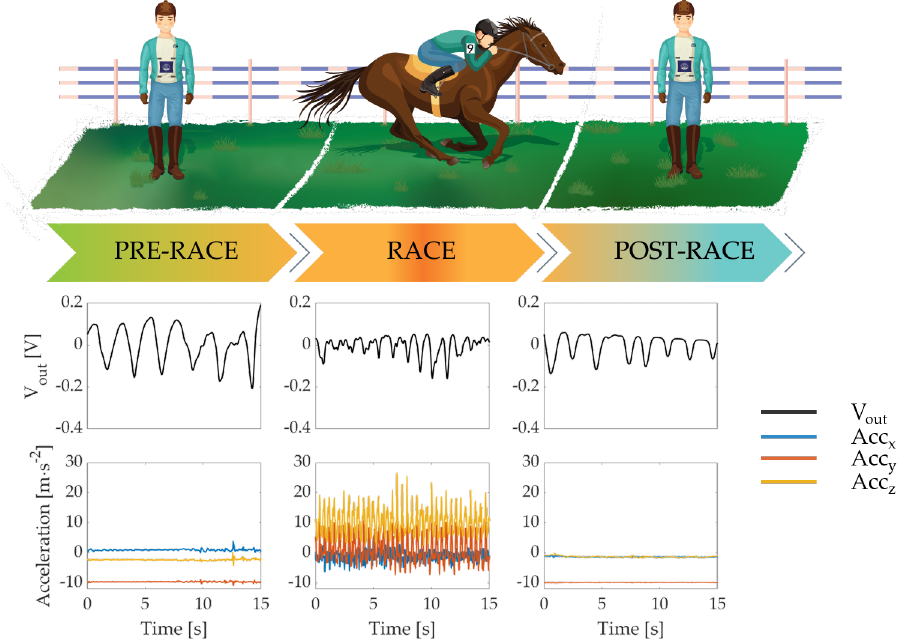
Figure 7. Graphical representation of the race phases and the related respiratory signal (black line) and the accelerometer data (blue, red and yellow